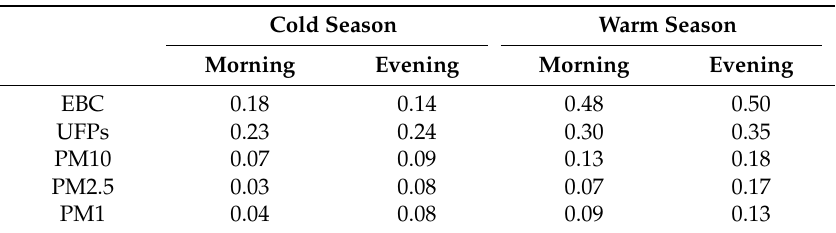
Table 4. Spatial coefficient of variation (CV) computed on seasonal and time of the day basis for EBC, UFP, and PM mass concentration